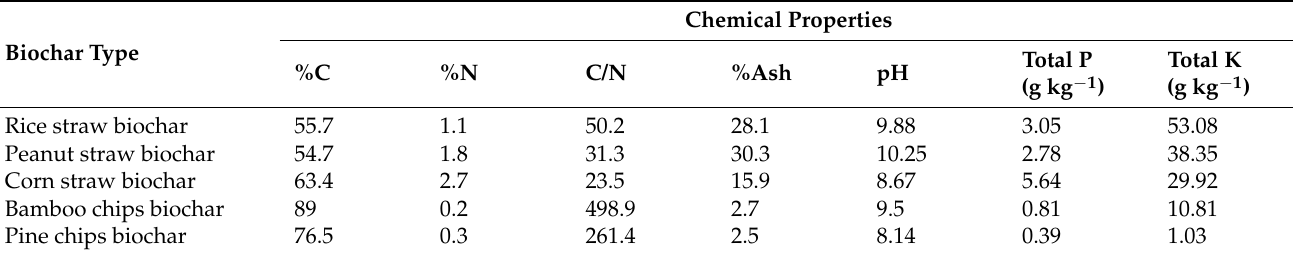
Table 1. Chemical properties of biochars produced from different feedstocks (Li et al. [72]).